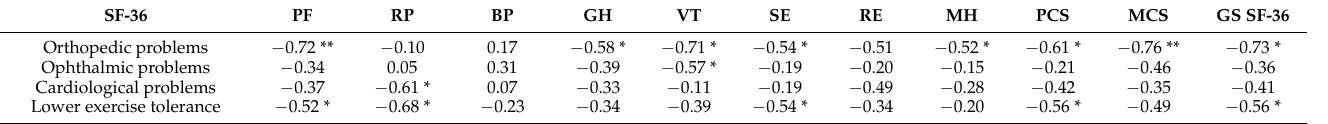
Table 6. Correlations of a subjective assessment of the effects of health problems on life in the evaluation of people with Marfan syndrome and the quality of